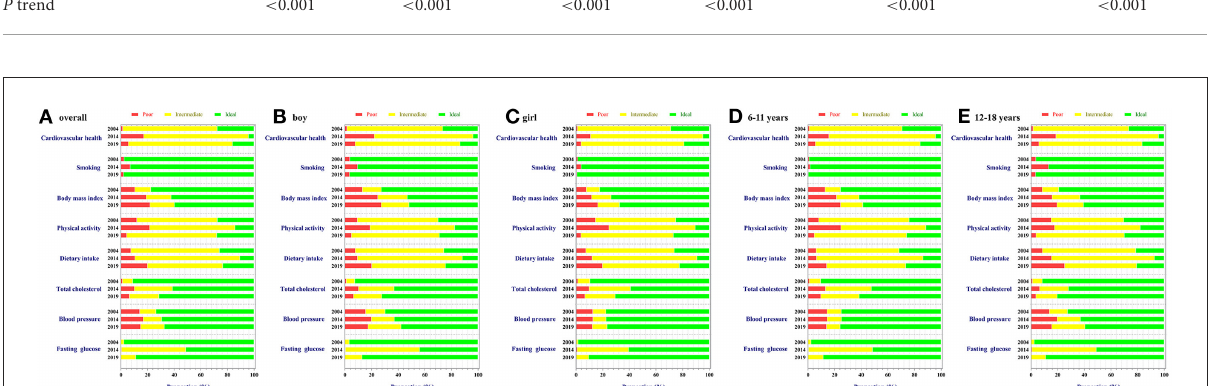
FIGURE1 Trends in poor, intermediate, and ideal CVH metrics among children and adolescents in Beijing: 2004 to 2019. (A–E) Stand for proportions of CVH metrics status in overall population, boys, girls, children aged 6–12 years, and children aged 12–18 years, respectively.